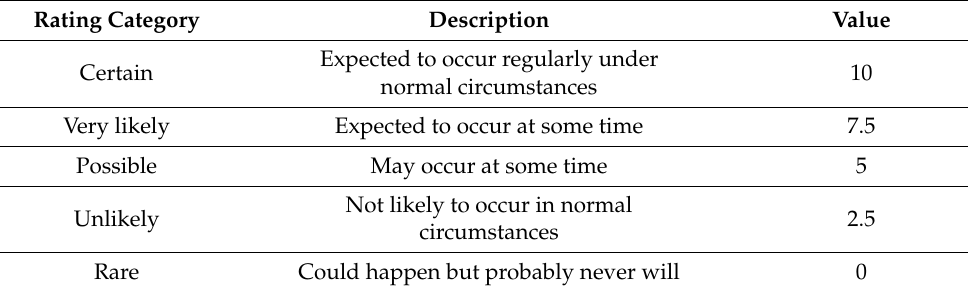
Table 1. Likelihood of events expressed by the frequency of its